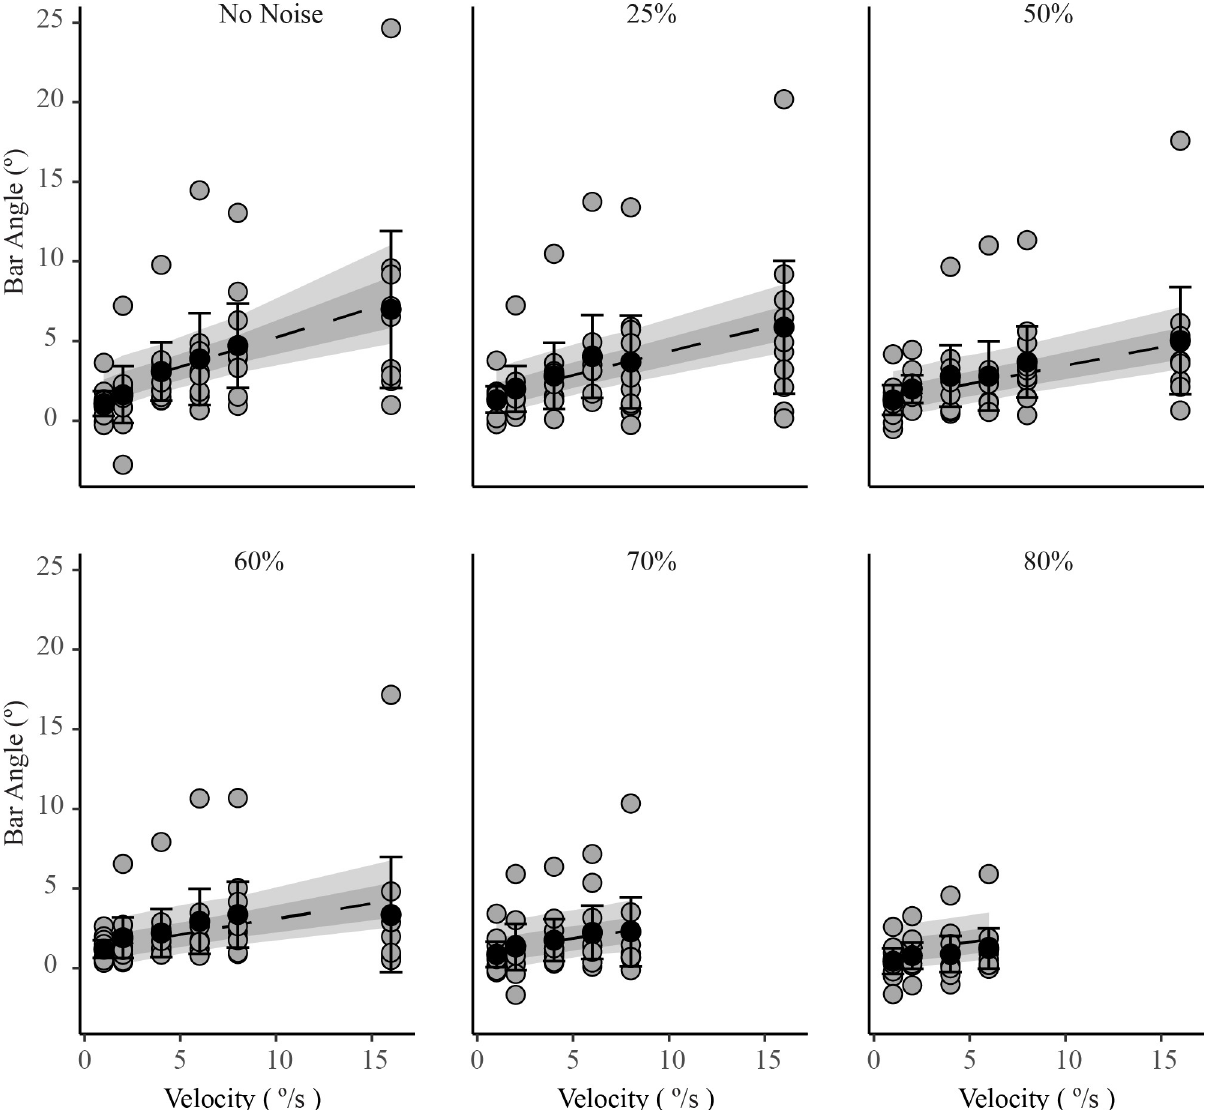
Fig 4. Linear multilevel mixed effects model with sample mean and individual data displaying the effect of increasing velocity on perceived vertical. Higher velocities biased vertical more than lower velocities and the size of the effect depends on the noise level. Each subject’s mean bar angle for the last 13s of visual motion in each trial are shown as grey circles. Sample means are black circles (n = 10). The error bars are standard deviations. The segmented line is the bootstrapped linear multilevel mixed effects model mean and the shaded regions are the 68% and 95% confidence intervals for the